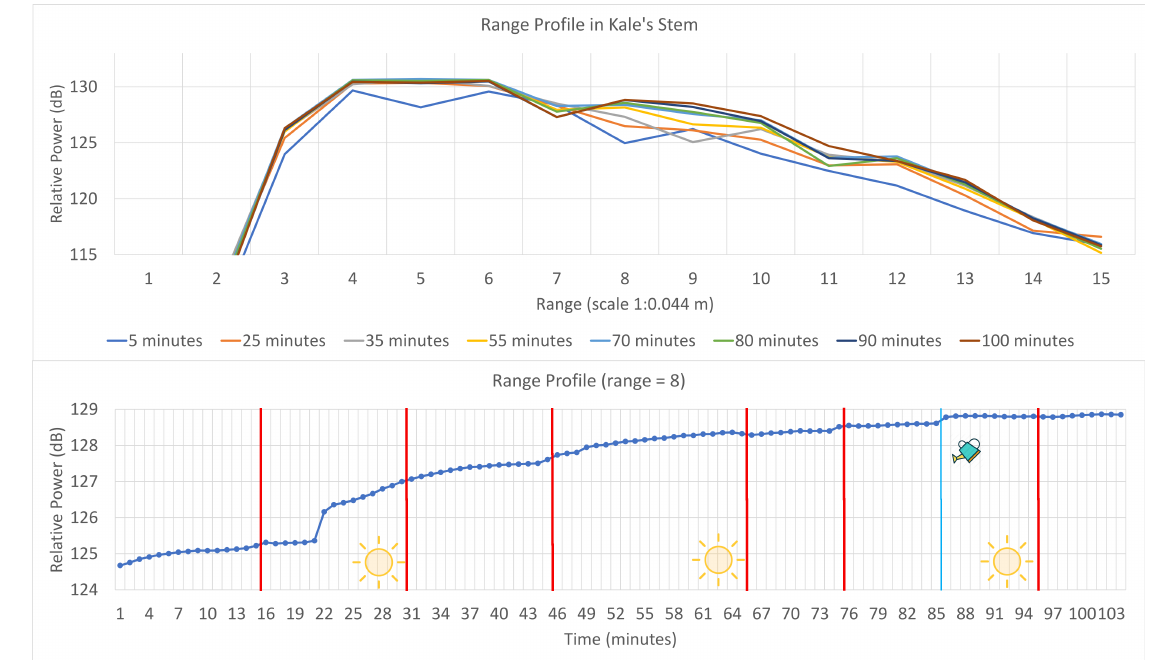
Figure 14. Result of the first test with kale’s stem; red lines—block or unblock of solar exposition; vertical blue line—watering.